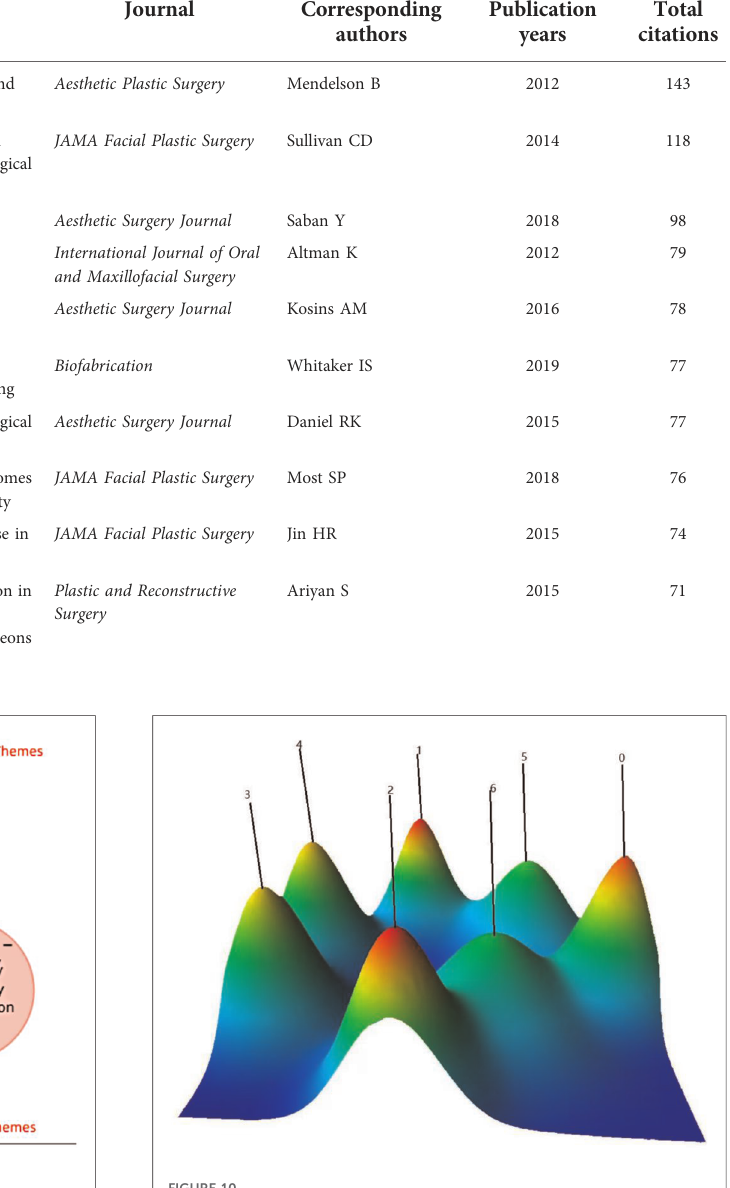
FIGURE 10 Mountain visualization of biclustering of highly frequent keywords and source literature studies on rhinoplasty